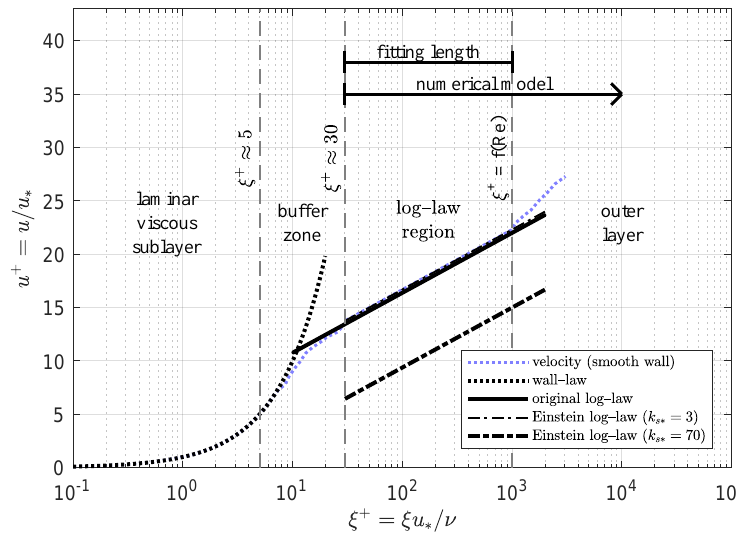
Figure 2. Velocity profile across the boundary